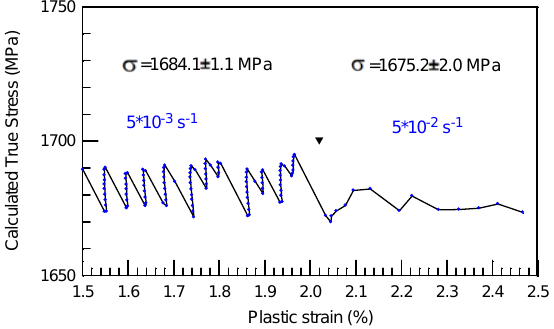
Figure 7. A part of the true stress-plastic strain curve (elastic strain is subtracted) obtained at the strain rates of 5 × 10 − 3 and 5 × 10 − 2 s − 1 . The data is taken from Reference [118] with permission of